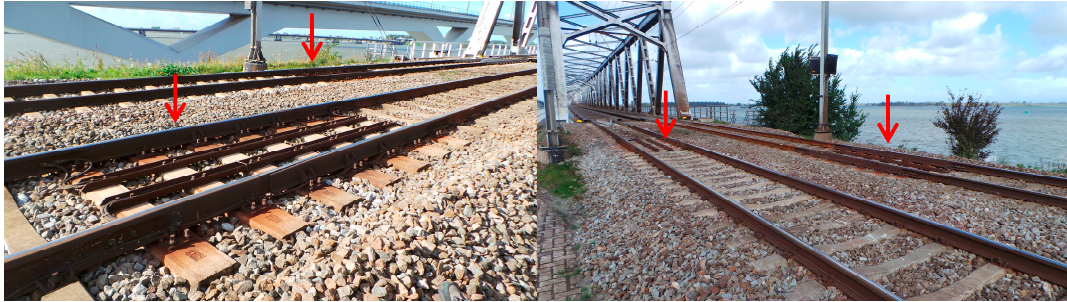
Figure 11. Expansion joints on the right side of the bridge.